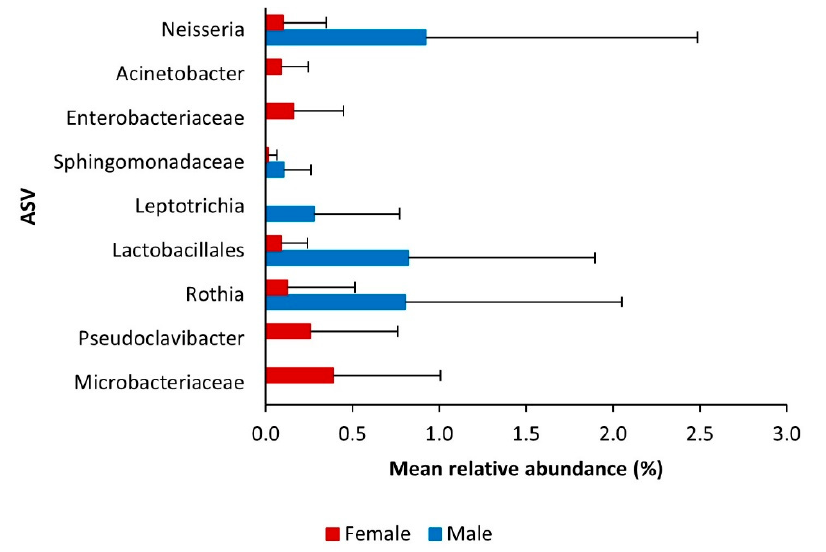
Figure 4. Mean relative abundance (%) of amplicon sequence variants (ASVs) classified at the genus level (order or family level if not further classifiable) and significantly differentially abundant between female and male P. cylindrus mycangia (Welch’s t -test, p < 0.05; Supplementary Table S6). Error bars represent standard deviation.